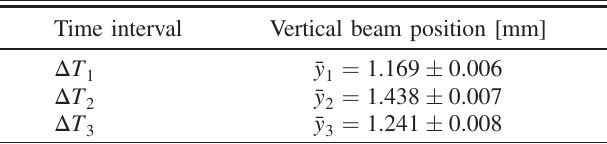
TABLE II. Average vertical beam positions ¯ y one run composed of six cycles, as shown in Fig.